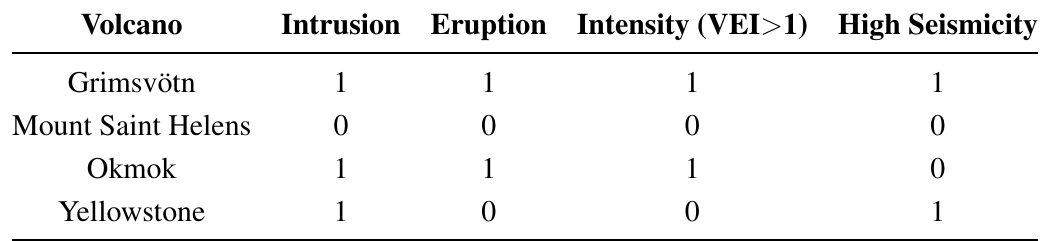
Table 5. Test event outcome for each algorithm stage and associated seismicity level, where 1 or 0 indicates whether the event occurred or not and if seismicity levels were high or